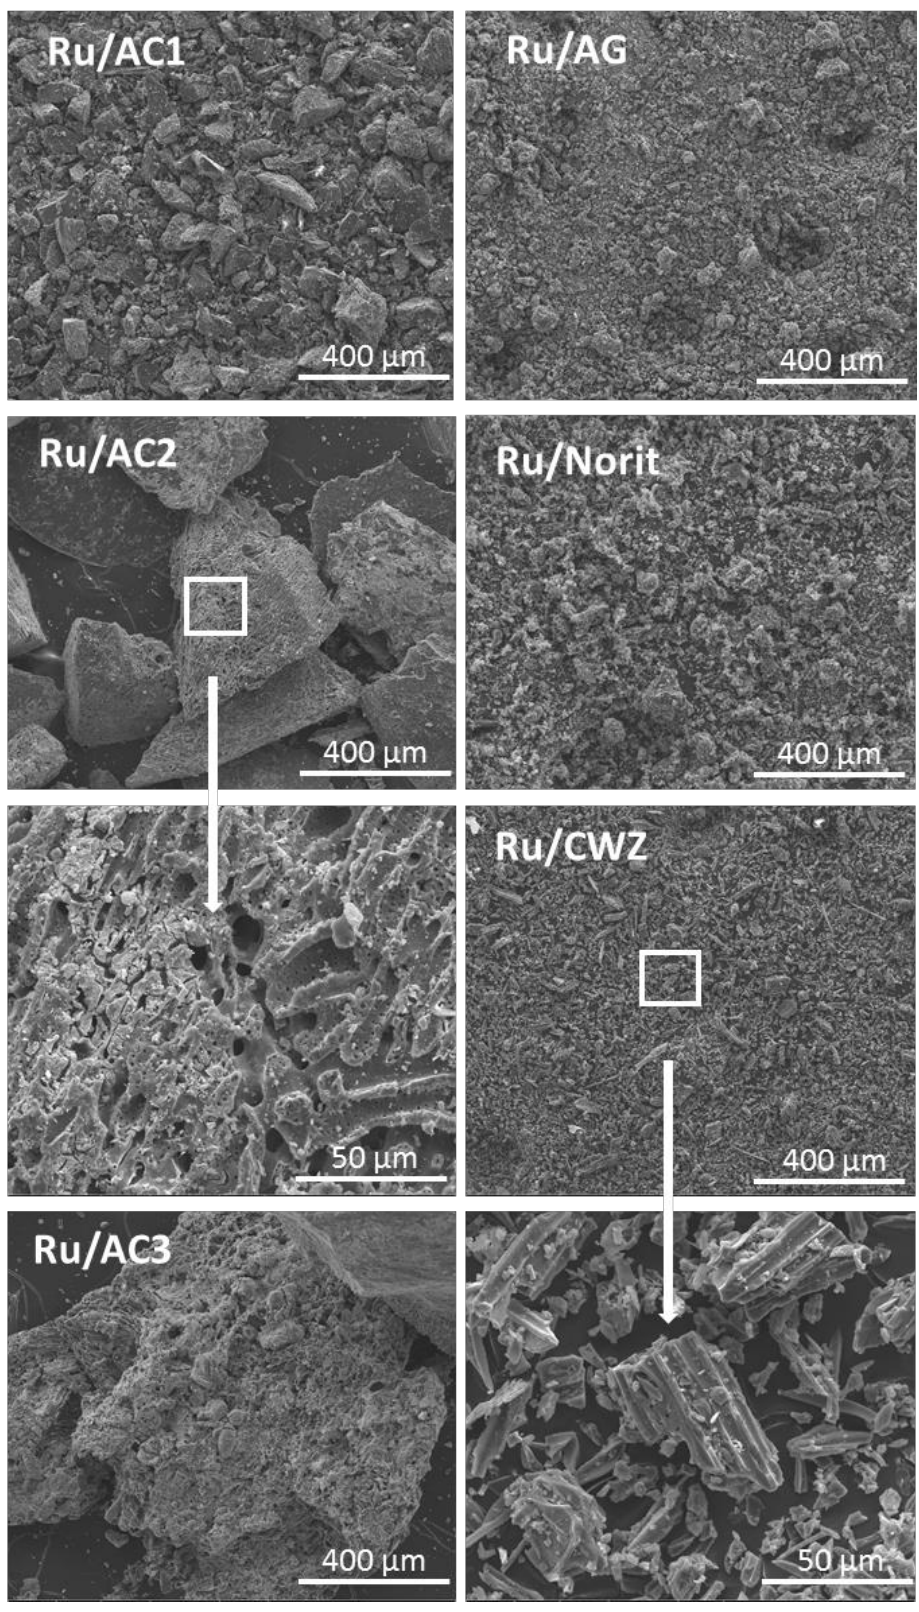
Figure 1. SEM images of ruthenium catalysts.